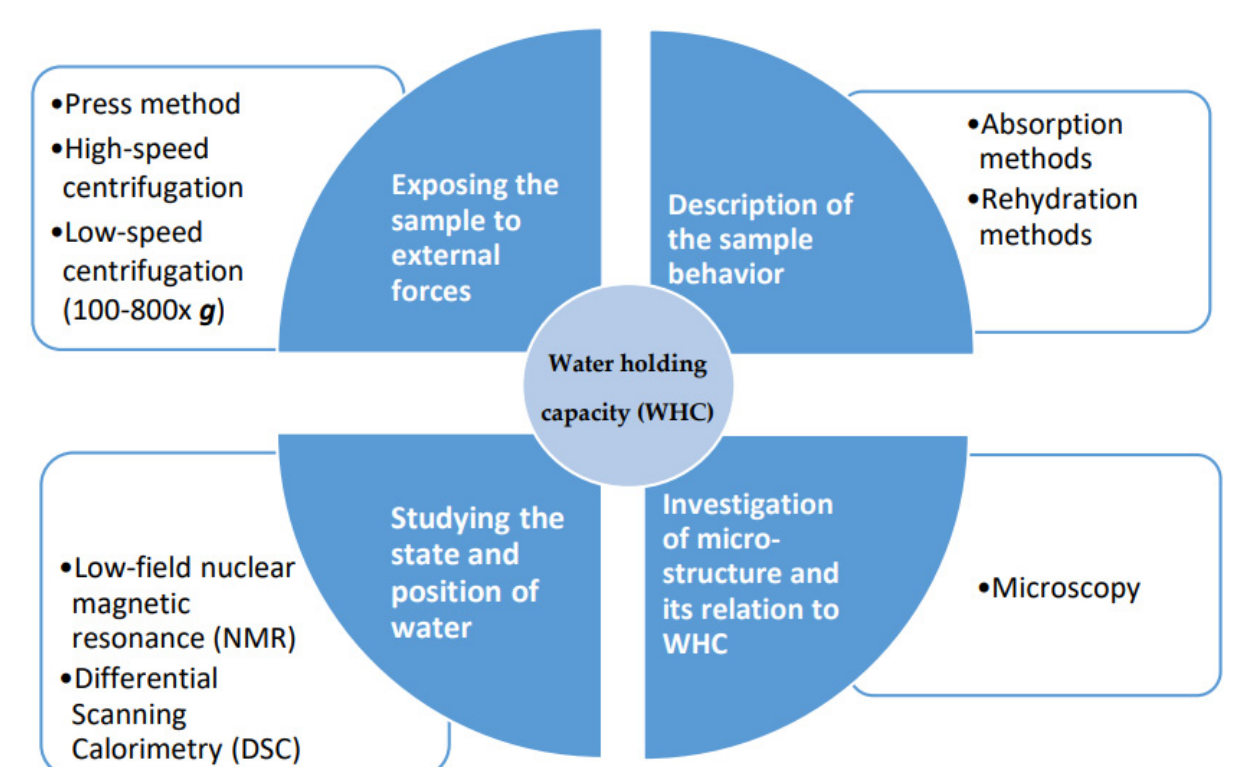
Figure 1. Various methods to measure water holding capacity (WHC). These can be divided into quantitative (the two upper) and qualitative methods (the two lower).